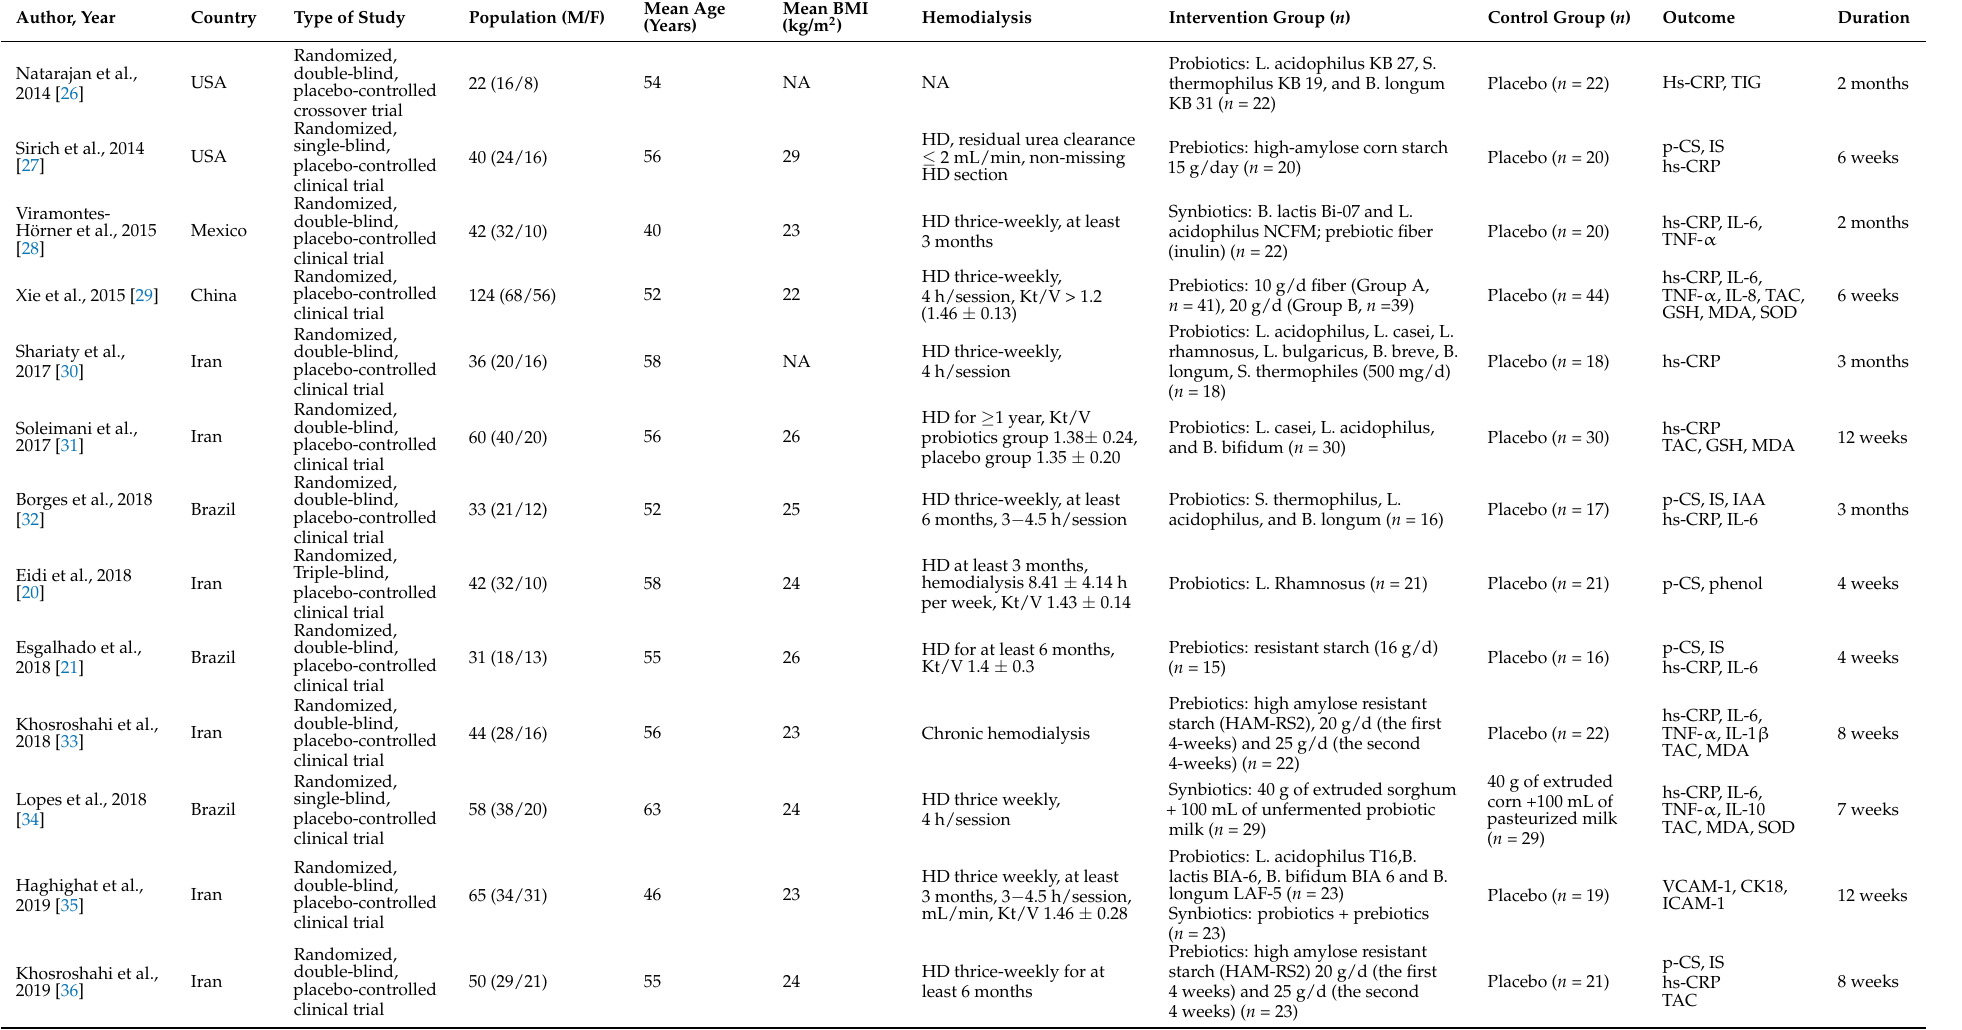
Table 1. Characteristics of included reports in systematic